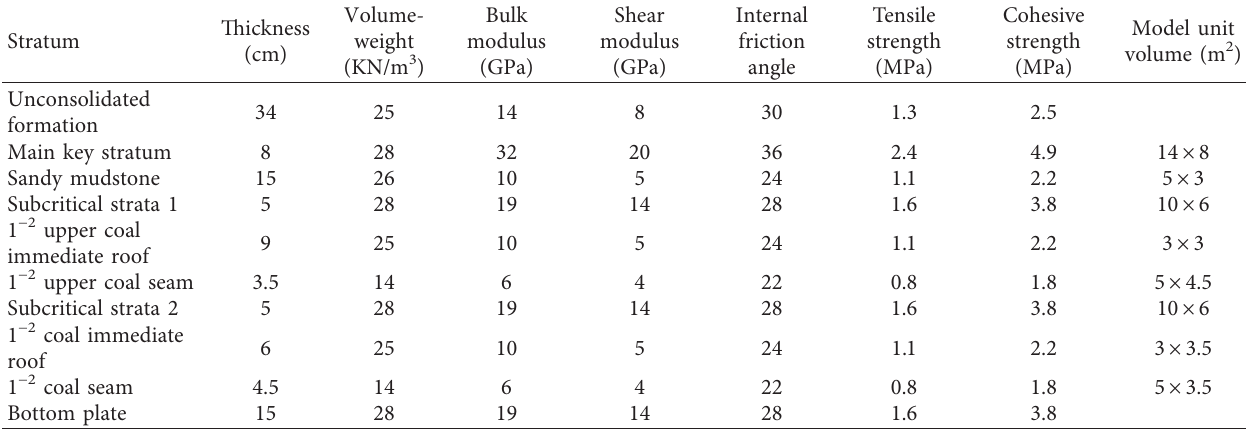
Figure 8: Numerical model calculation. Table 6: Parameters of the numerical model of rock strata.